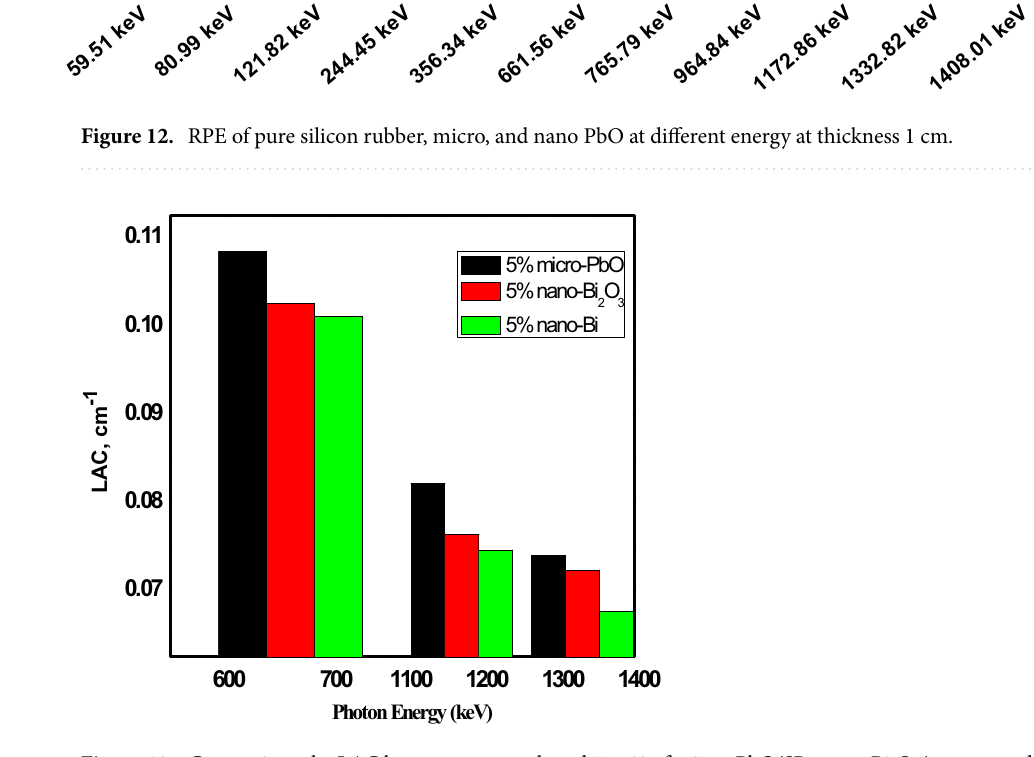
Figure 13. Comparison the LAC between our result and 5 wt% of micro-PbO/SR, nano-Bi 2 O 3 /unsaturated polyester, and nano-Bi/unsaturated polyester at 661, 1172 and 1332